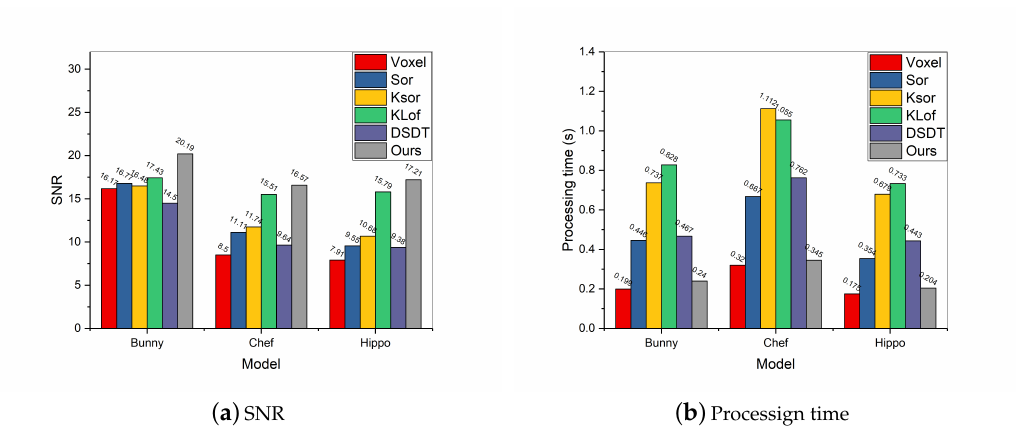
Figure 6. Evaluation of signal-to-noise ratio (SNR) and processing time on several filtering algorithms.